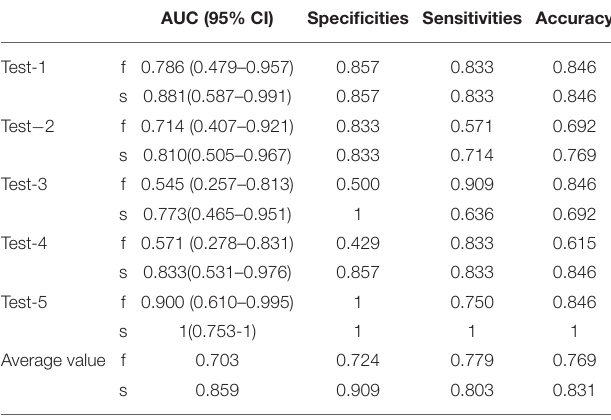
TABLE 3 | Diagnostic capacity of the f and s in the testing